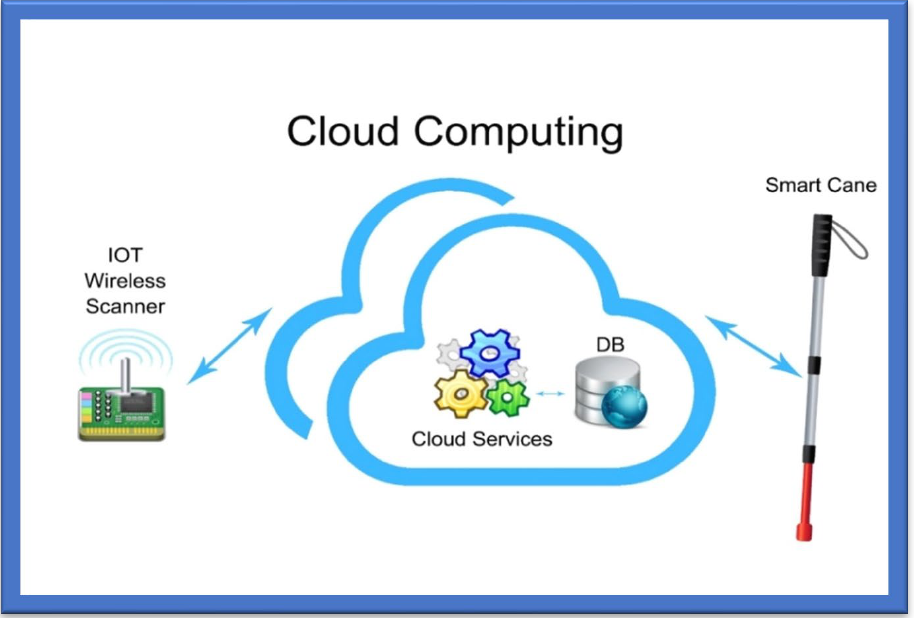
Figure 4. Smart Cane Navigation System.